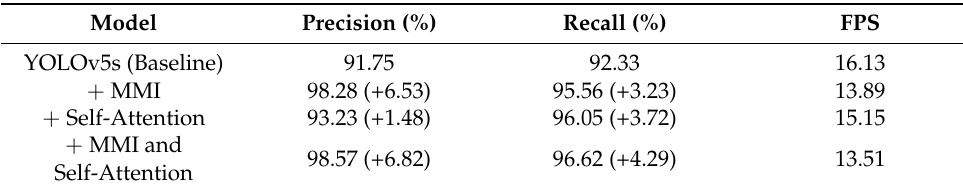
Table 2. Comparison of the precision, recall and FPS of different network structures on our parcel